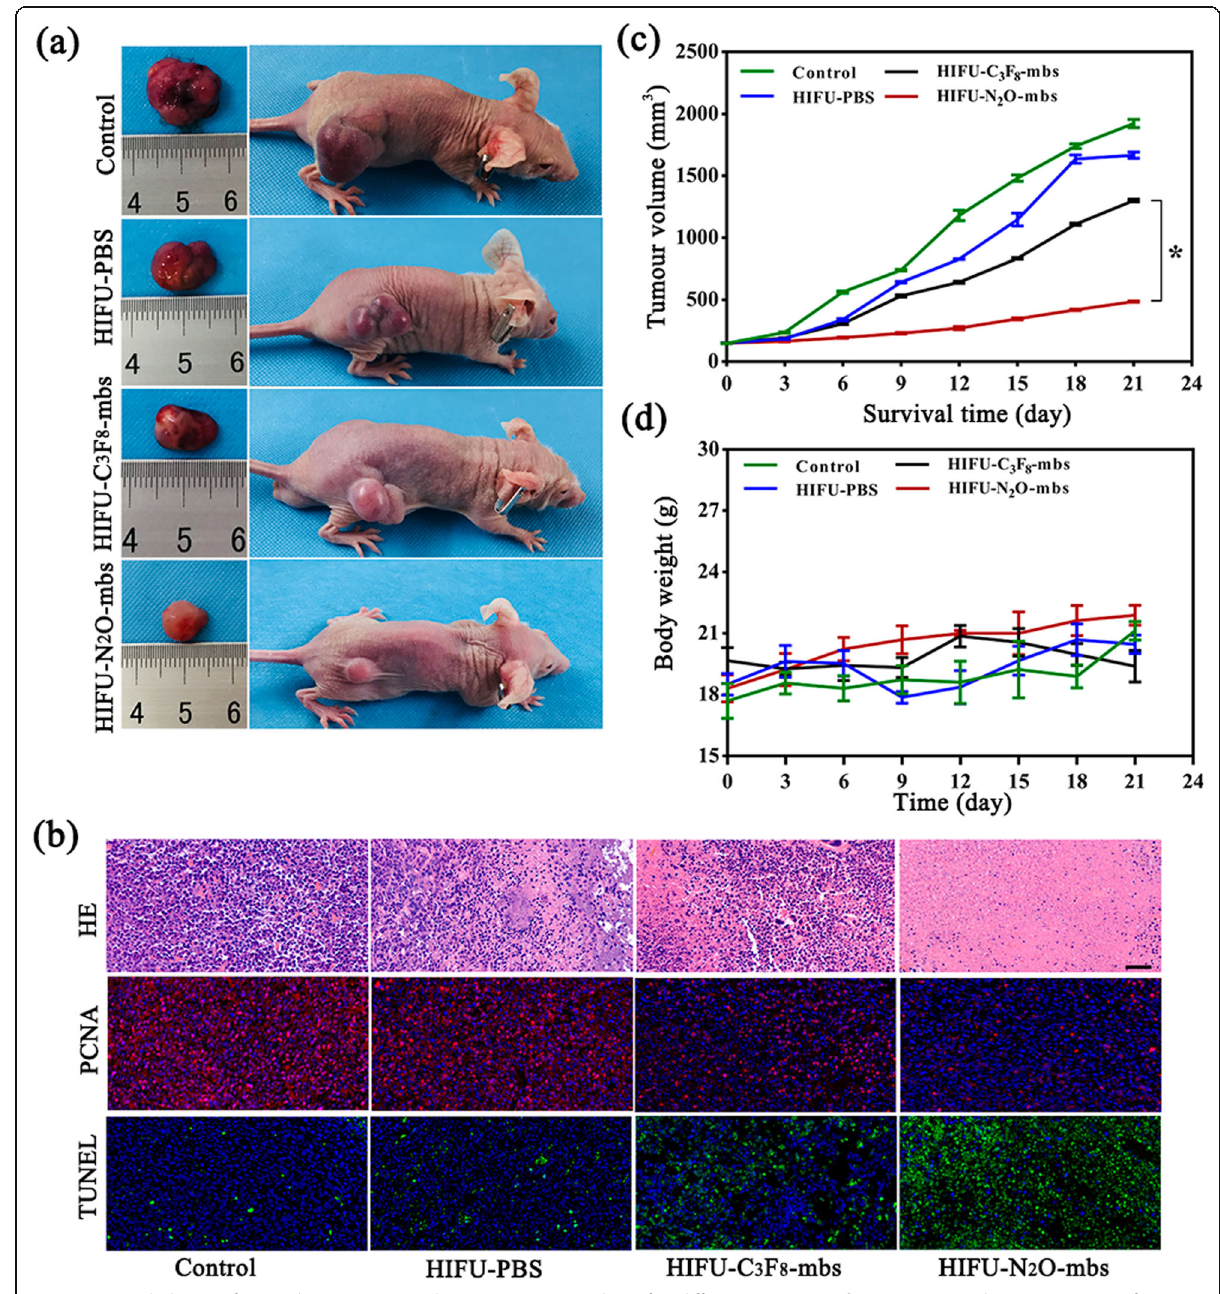
Fig. 7 a Digital photos of tumor-bearing mice and ex vivo tumors 21 days after different treatments; b H&E, PCNA and TUNEL staining of tumor sections after various treatments; c the corresponding calculated tumor volume of each group after 21 days of different treatments; d body weight of tumor-bearing mice for each group. The scale bars in HE staining are 100 μ m; the scale bars in TUNEL and PCNA staining are 50 μ m. (The data were shown as mean ± SD, n = 5 per group, * p < 0.05, compared with HIFU-C 3 F 8 -mbs